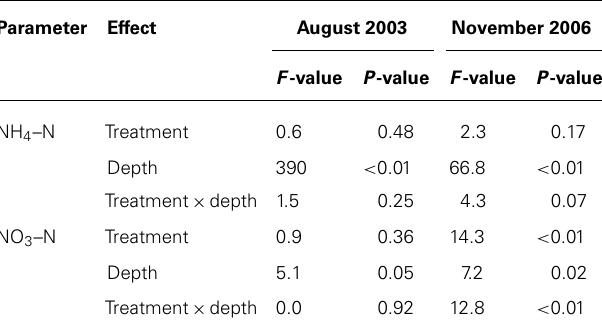
Table 2 | Results of split-plotANOVA examined for effects of N fertilization (treatment) and soil depth (depth) on concentrations of inorganic nitrogen (NH 4 –N and NO 3